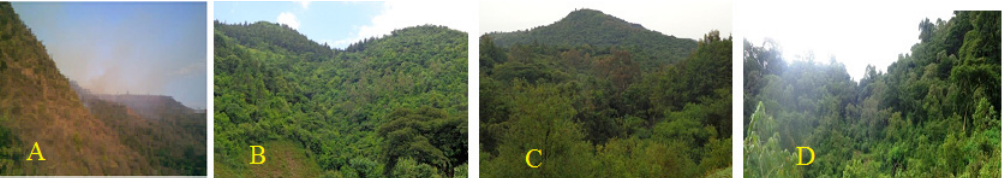
Figure 3. Dry Afromontane forests in ( A ) Wondo Genet, ( B ) Taragedam, ( C ) Alemsaga, and ( D ) Banja where sporocarps collections were conducted (photo credits: 3A, Tatek Dejene; 3B–3D, Demelash Alem).